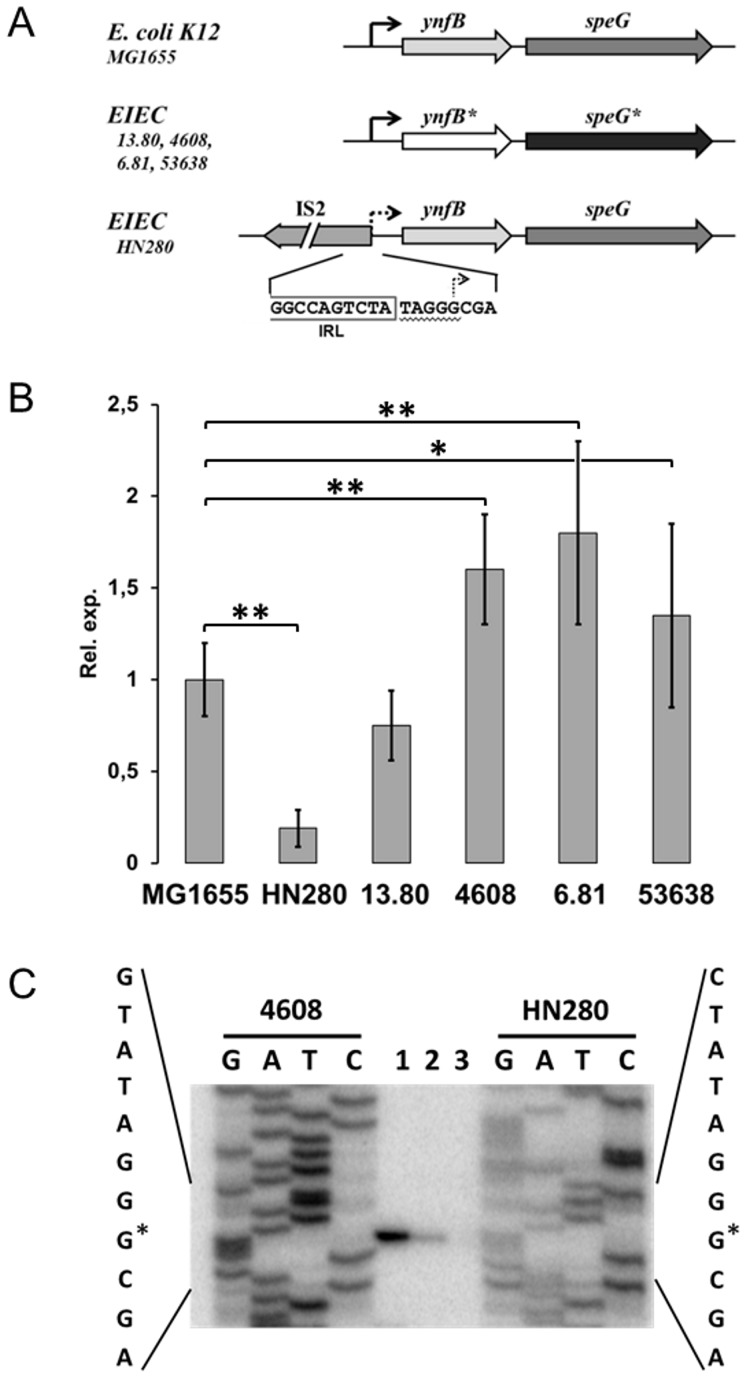
Molecular and functional analysis of the ynfB-speG operon in EIEC.(A) Genetic organization of the ynfB-speG operon in EIEC strains. The operon at the top is based on the E. coli K-12 MG1655 sequence as reported in (National Center of Biotechnology Information, Bethesda, Md.). The right-pointing arrow marks the transcription start site (+1). The asterisk (*) indicates genes carrying non-synonymous mutations. The nucleotide sequence at the bottom refers to the IS2 insertion into the ynfB-speG promoter of EIEC HN280 (IRL: left-end inverted repeat of IS2. Underlined: direct repeat at the IS2 insertion site). (B) Relative speG transcription in EIEC strains as monitored by in vivo Real-Time PCR using MG1655 as a control. Strains were grown at 37°C in M9 complete medium. At least three wells were run for each sample and the error bars display the calculated maximum (RQMax) and minimum (RQMin) expression levels that represent standard error of the mean expression level (RQ value). * denotes 0.05>p≥0.01; ** denotes p<0.01. (C) Primer extension analysis of the transcripts generated under the control of the ynfB-speG promoter of EIEC strains HN280, 13.80, and 4608. The autoradiograph is the result of a typical experiment performed with the peg primer on RNA extracted from strain 4608 (lane 1), 13.80 (lane 2), and HN280 (lane 3). Lanes G, A, T, and C show the sequencing ladder generated with the same primer. The asterisk marks the transcription start site (+1).